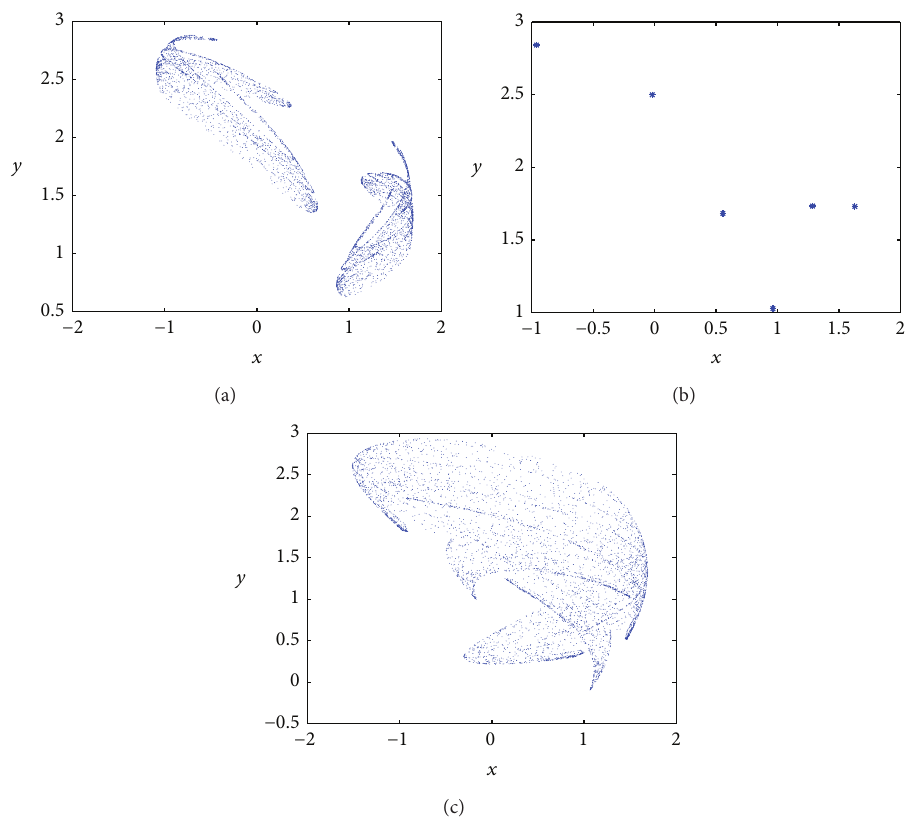
Figure 7: Phase portraits corresponding to Figure 6: (a) 𝑏 = 0.85 , (b) 𝑏 = 0.88 , and (c) 𝑏 = 1 .